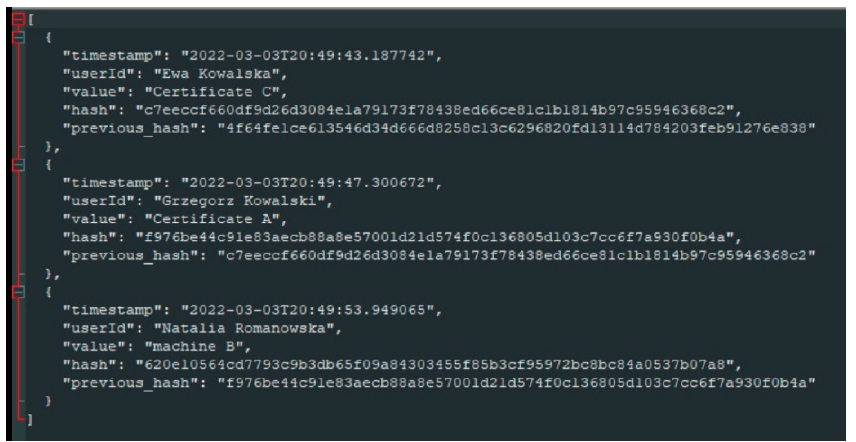
Figure 12. A piece of encoded data in BC.